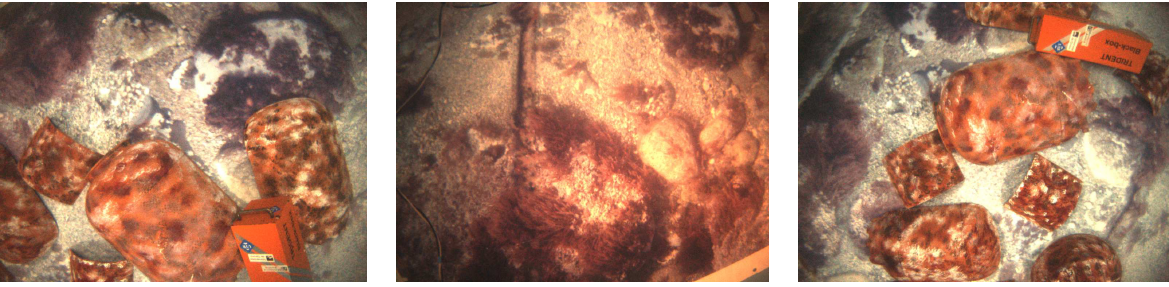
Figure 10. Examples of images obtained during the